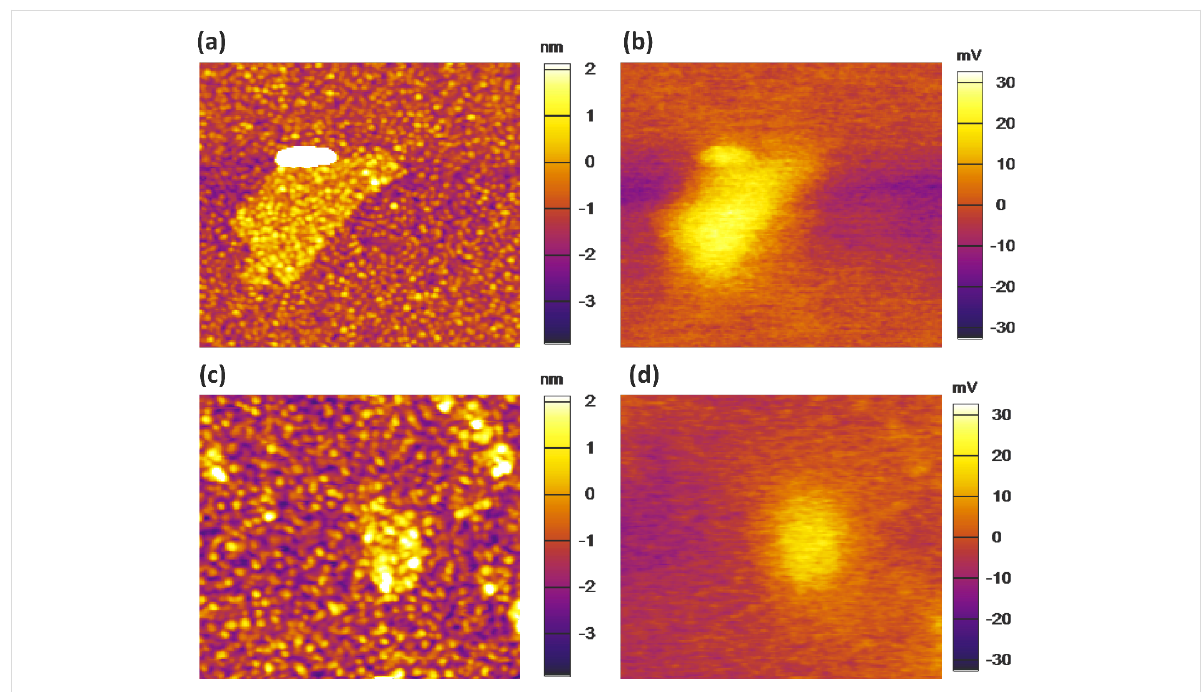
Figure 2: AFM and KPFM images of (a) and (b) a GO flake (2 × 2 μ m); (c) and (d) a GO-Cs flake (1.4 × 1.4 μ m).